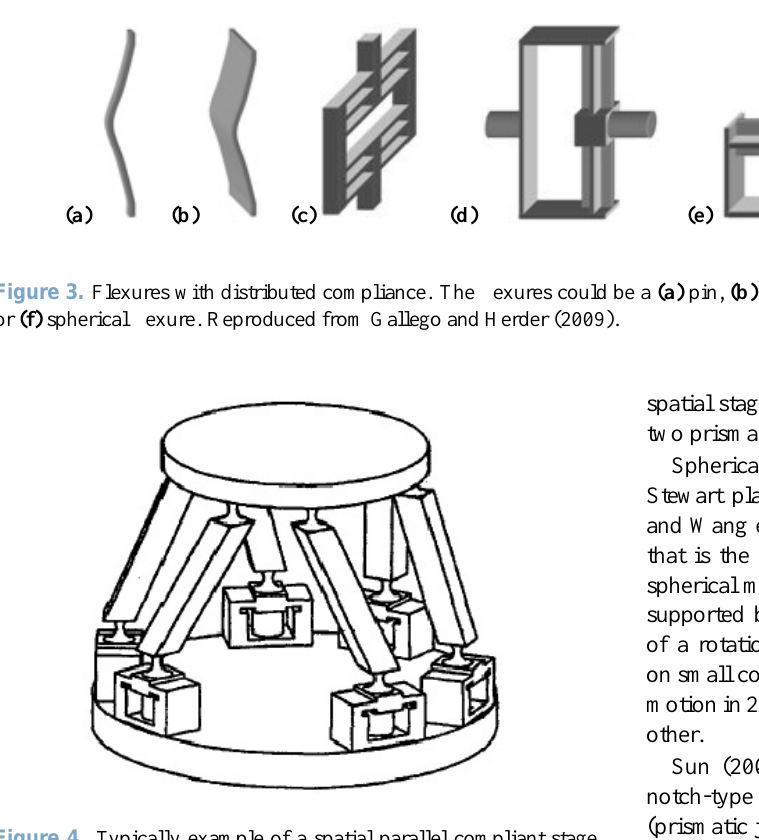
Figure 4. Typically example of a spatial parallel compliant stage (Liu et al., 2001). The platform is supported by legs, with compliant joints at both